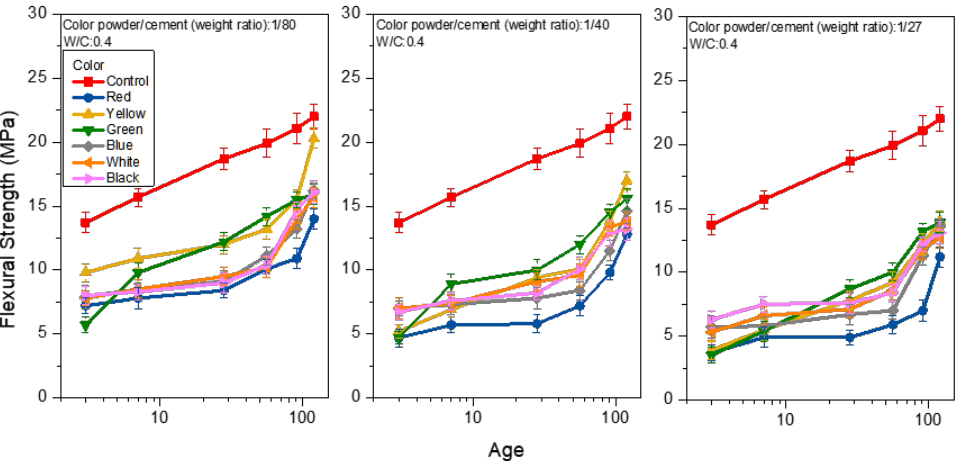
Figure 8. Flexural strength of colored mortar at W/C = 0.4 and under saturated limewater curing when weight ratios of color powder/cement at 1:80, 1:40, and 1:27 are added.